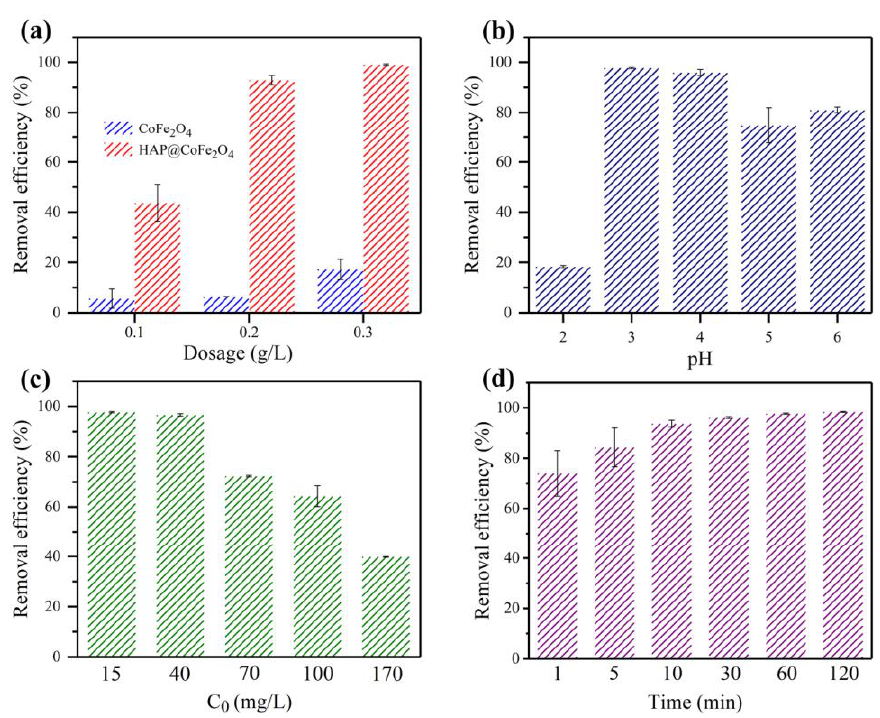
Figure 2. ( a ) Effect of dosage on the U(VI) adsorption of CoFe 2 O 4 and HAP@CoFe 2 O 4 at various dosages (Reaction conditions: initial U(VI) concentration = approximately 15 mg/L, pH = 3.0, adsorbent dosage = 0.1 – 0.3 g/L, T = 298 K); ( b ) Removal rate of U(VI) by magnetic HAP@CoFe 2 O 4 under various pH (Reaction conditions: initial U(VI) concentration = approximately 15 mg/L, pH = 2.0 – 6.0, adsorbent dosage = 0.2 g/L, T = 298 K); ( c ) Effect of initial U(VI) concentration (reaction conditions: initial U(VI) concentration = 15 – 170 mg/L, pH = 3.0, adsorbent dosage = 0.2 g/L, T = 298 K); ( d ) Effect of contact time (reaction conditions: initial U(VI) concentration = approximately 15 mg/L, t = 0 – 120 min, pH = 3.0, adsorbent dosage = 0.2 g/L, T = 298 K).